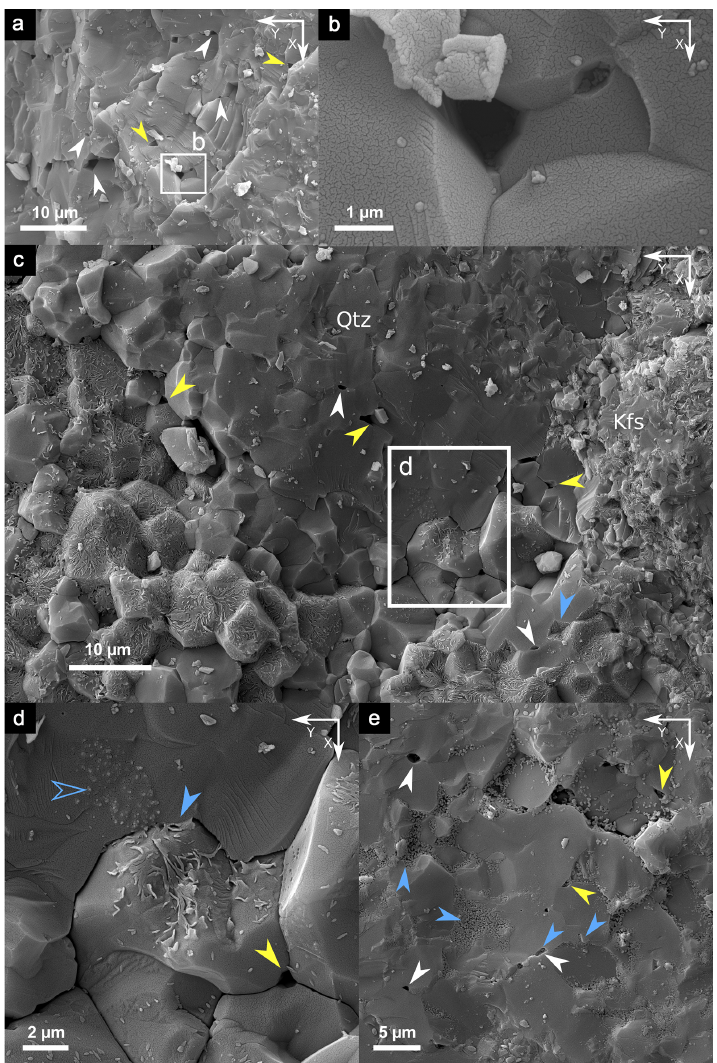
Figure 6. Secondary electron images from broken surfaces of quartz domains. White and yellow arrows point respectively to pores on grain boundaries with a low angle to the YZ plane of finite strain and to pores at grain-boundary trip junctions. Blue arrows highlight “precipitation” features, with the empty blue arrow in panel (d) identifying crystallites interpreted to be incipient precipitates found on a less dilatant grain boundary. Panel (a) shows a thick, coherent, monomineralic quartz domain that has an abundance of pores. Panel (b) highlights the difference between a pore found at a triple junction and a pore found in the middle of a grain boundary (see Fig. 1c for comparison in XZ plane). Panels (c) , (d) and (e) show the change in porosity and grain-boundary features with increasing distance from a plagioclase porphyroclast (see text for more